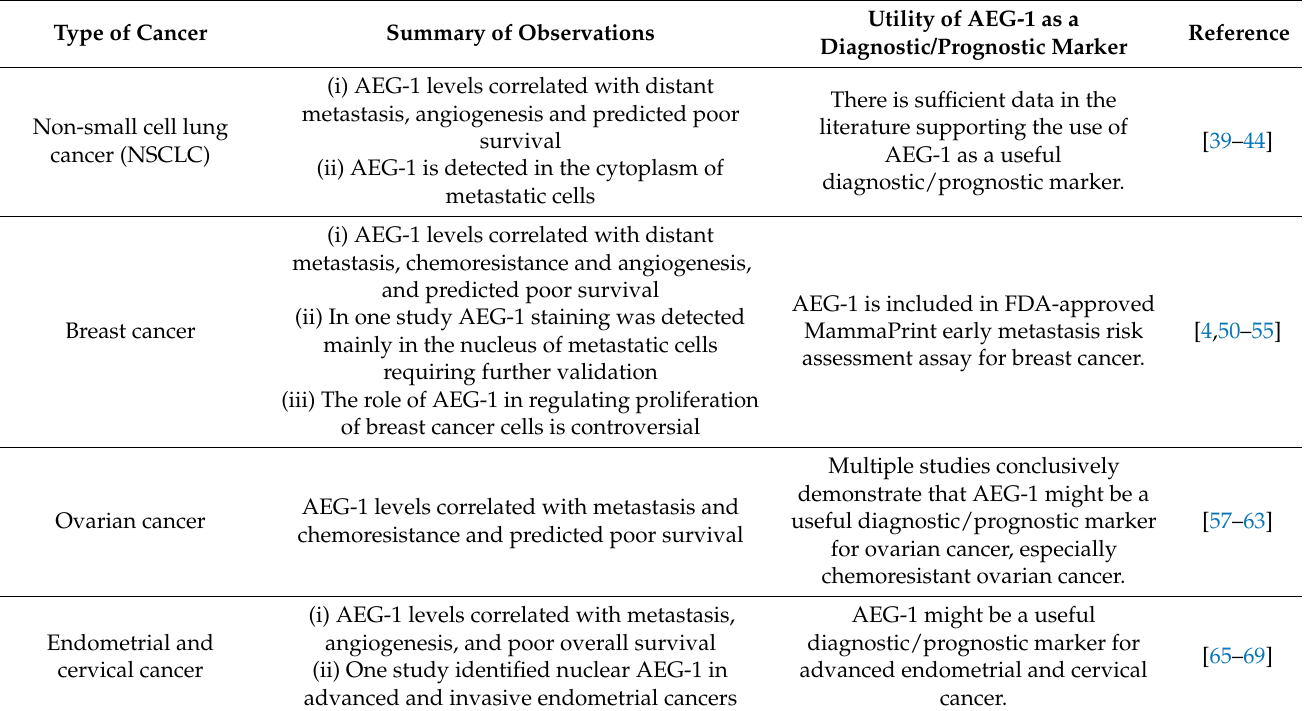
Table 1. Utility of AEG-1 is a diagnostic/prognostic marker for multiple